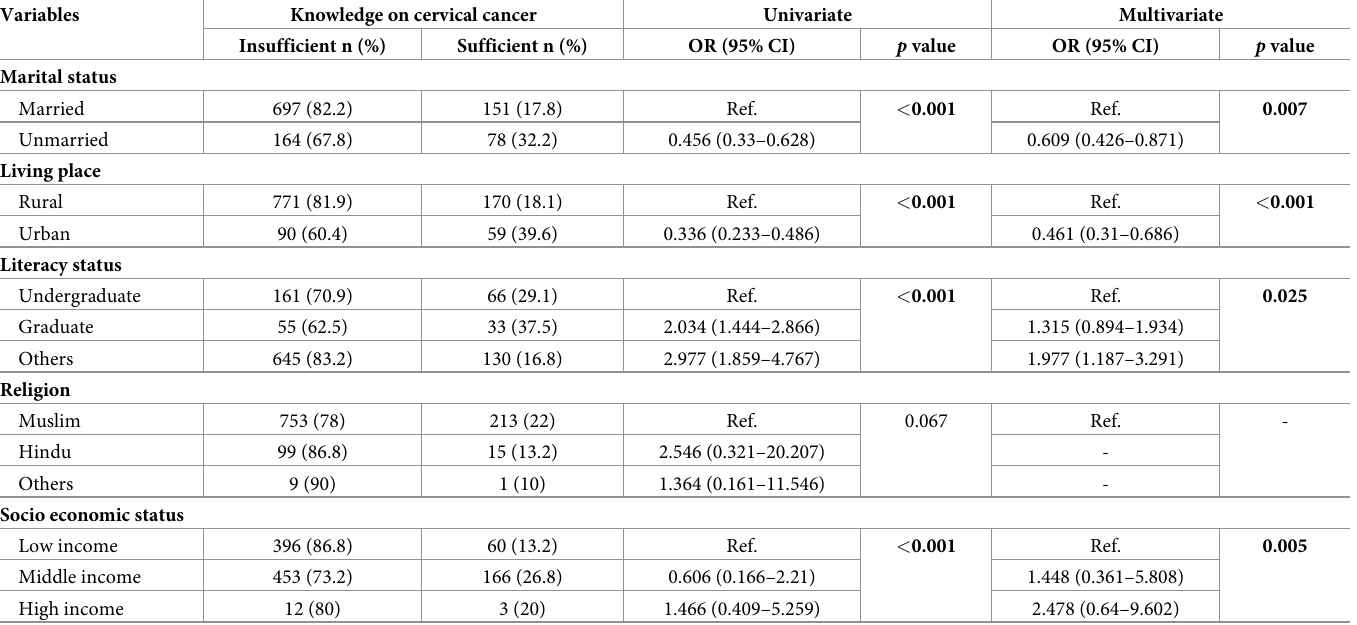
Table 5. Univariate and multivariable analyses of factors associated with knowledge on cervical